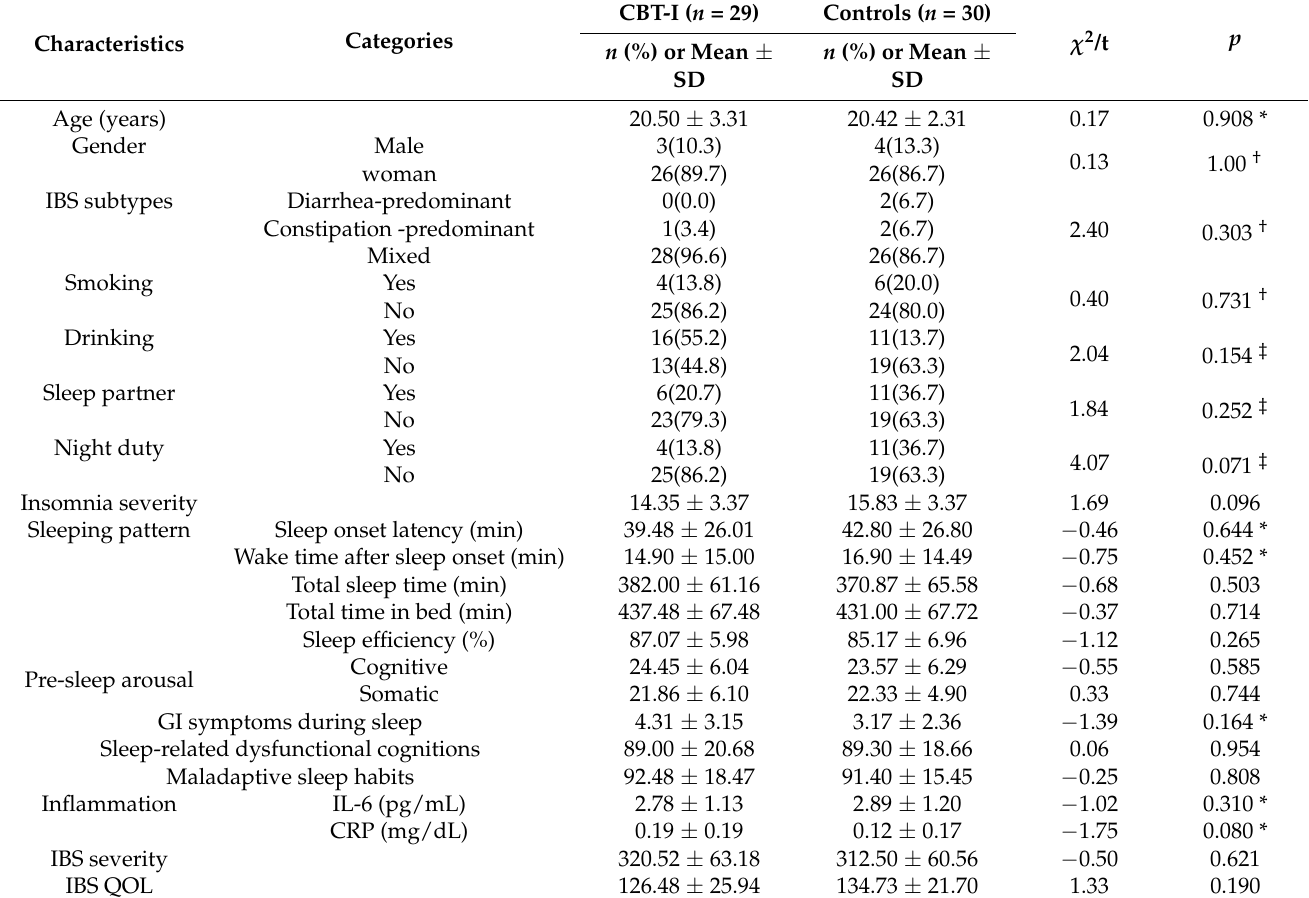
Table 2. Baseline characteristics and homogeneity of participants ( n =